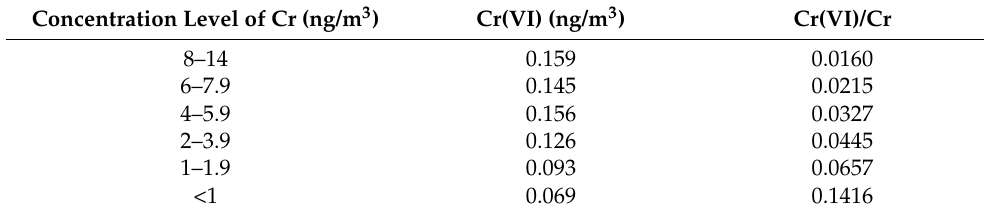
Table 5. Classification table of Cr(VI)/Cr.